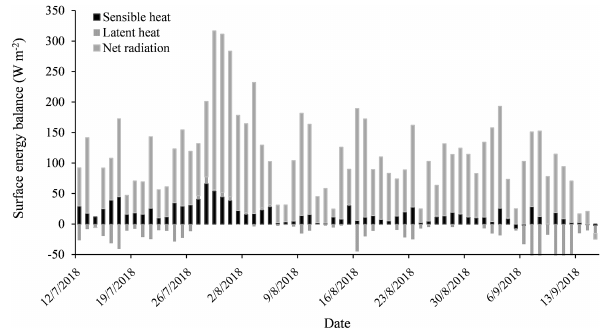
Figure 8. Daily mean energy balance at the middle of the glacier study site, which was close to the automatic photogrammetry